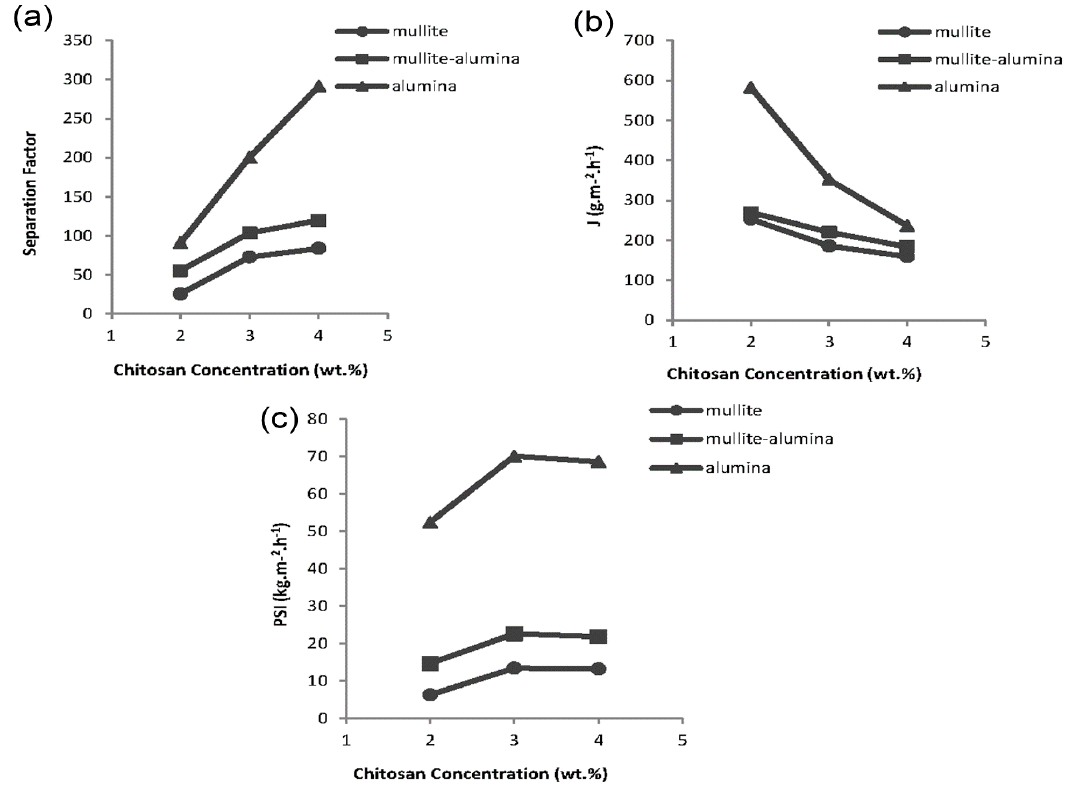
Figure 5. The pervaporation performance of membranes with different chitosan concentrations covered on different supports. ( a ) separation factor; ( b ) permeation flux; ( c ) pervaporation separation index ( PSI ) .